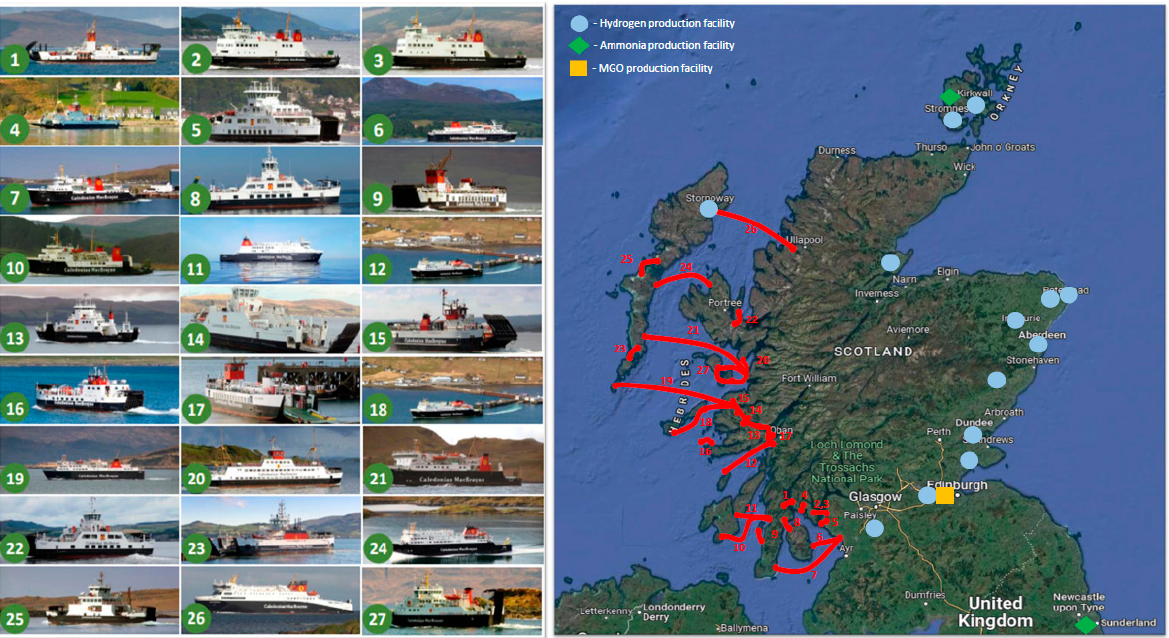
Figure 2. Perspective picture of case ships and diagram of case routes (red line) with fuel production locations in Scotland. Table 4. Detailed ship specifications and routes. Ship No.